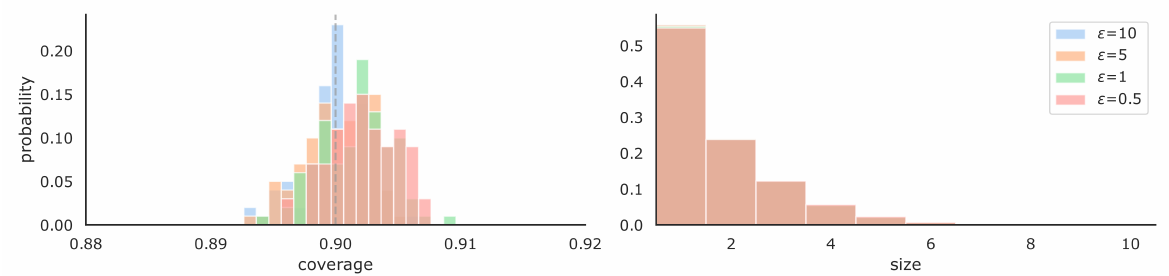
Figure 6: Coverage and set size for different values of ϵ . We demonstrate the performance on ImageNet of private conformal prediction using a nonprivate ResNet-152 as the base model with α = 0 . 1. The coverage improves slightly for liberal (large) ϵ , although the cost of privacy is evidently very low. All of the histograms on the right hand side are overlapping. See Section 4.3 for details.